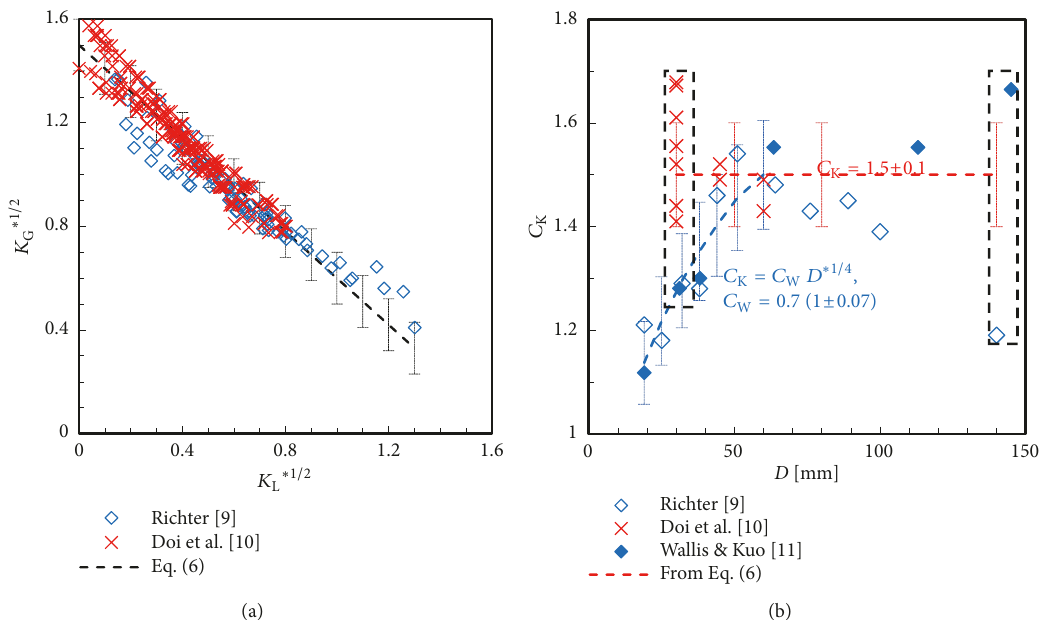
Figure 1: CCFL characteristics at square top ends: (a) CCFL expressed by Kutateladze parameters and (b) CCFL constant (broken-line box: disagreement between